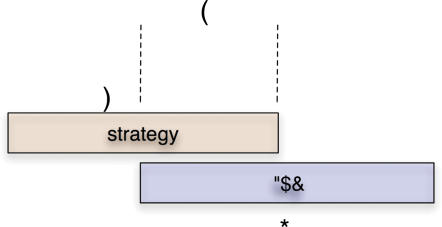
Consider a pleiotropic gene that encodes both strategy and tag. The first n bits encode the strategy according to a parity rule: if the sum of the first n bits is even, the strategy is cooperation, otherwise it is defection. The last m bits encode the tag. Each sequence encodes a different tag. Hence there are 2m possible tags. There is an overlapping region of L bits which affect both the strategy and the tag. This setup allows evolution of tag based cooperation if b/c>(2n−L)/L is fulfilled.